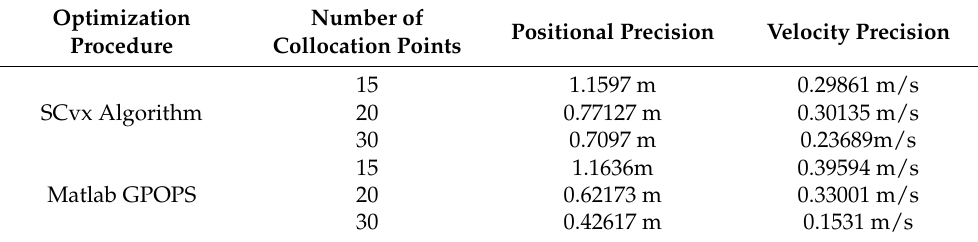
Table 5. Precision Comparison with Different Number of Collocation